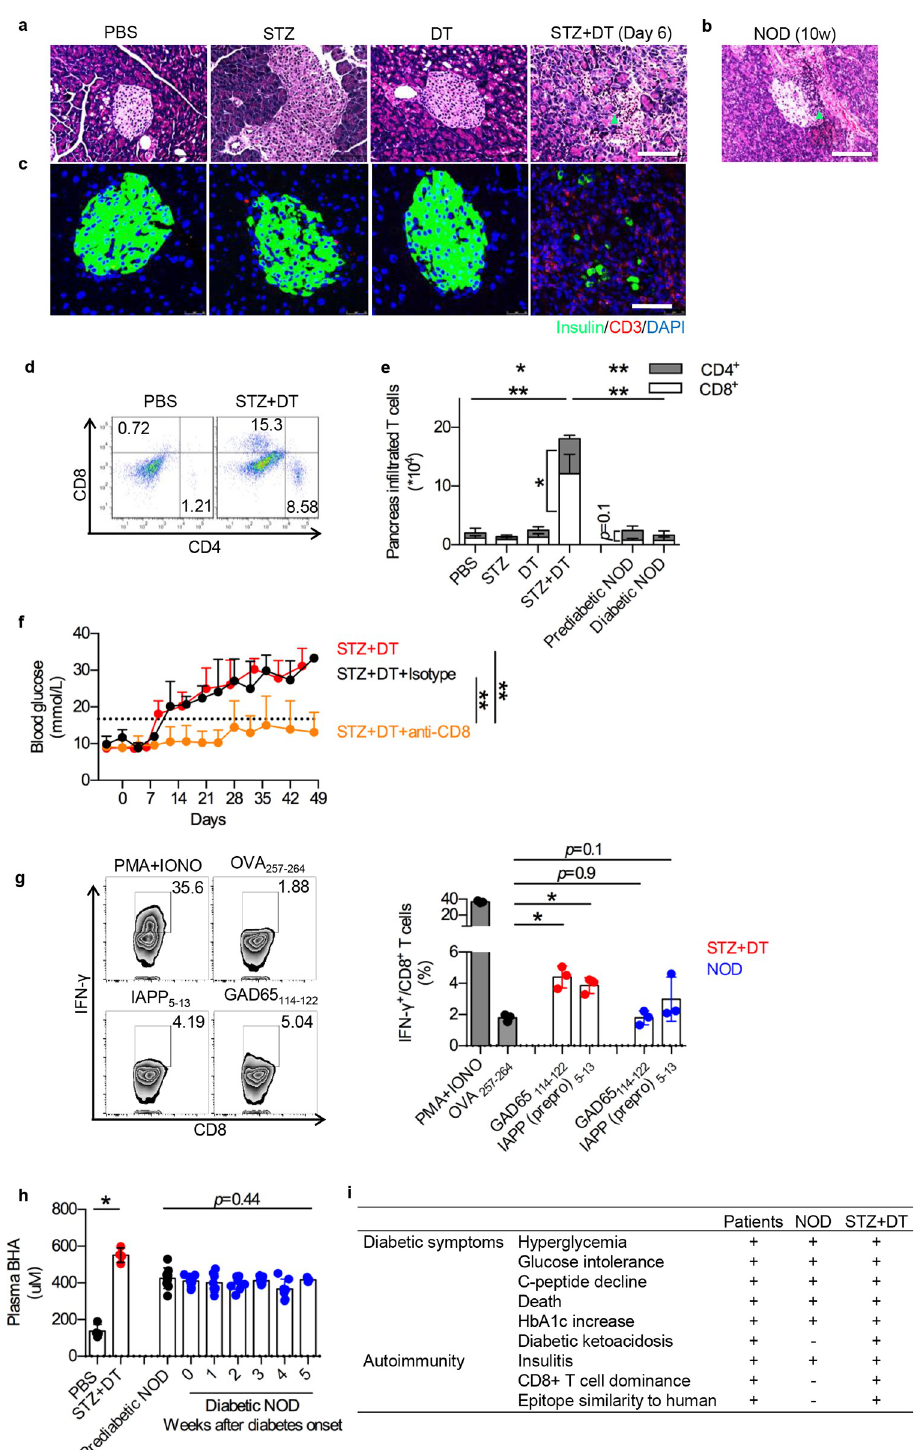
Fig 3. CD8 + T cell infiltration and severe ketoacidosis in STZ+DT mice. a-b . H&E staining of islets from STZ+DT mice and control groups at day 6 ( a ), and prediabetic NOD mice at 10-week old ( b ). Arrow pointed at inflammatory infiltrates. c . Immunofluorescence of CD3 (red), insulin (green) and DAPI (blue) of islets. Scale bars represent 50 μ m. d . T cells subsets in pancreatic infiltrates. CD8 + and CD4 + T cells were identified by flow cytometry. Mice age as in 3a and 3b. e. Statistical analysis of 3d. Difference was calculated between STZ+DT and control groups (top left, horizontal